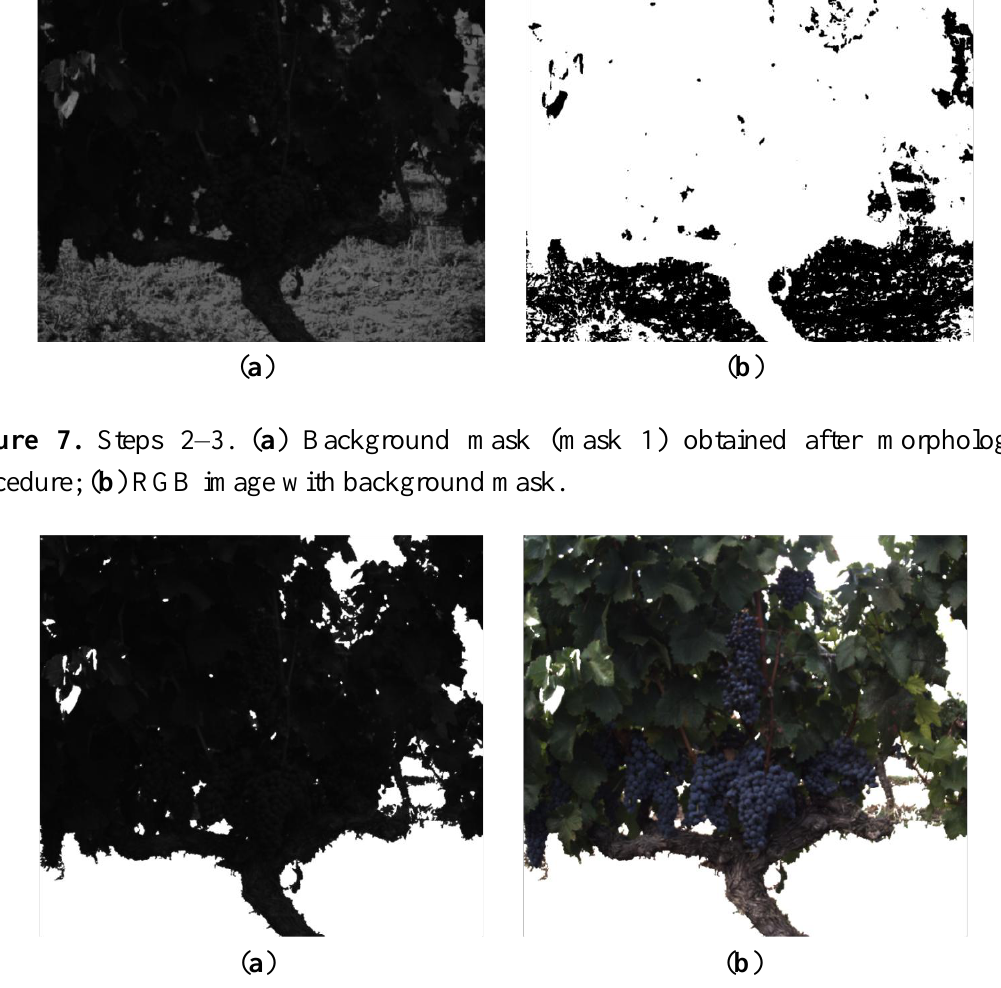
Figure 8. Steps 5–6. ( a ) K-means clustering applied to the ‘a*b*’ space; ( b ) Fruits mask (mask